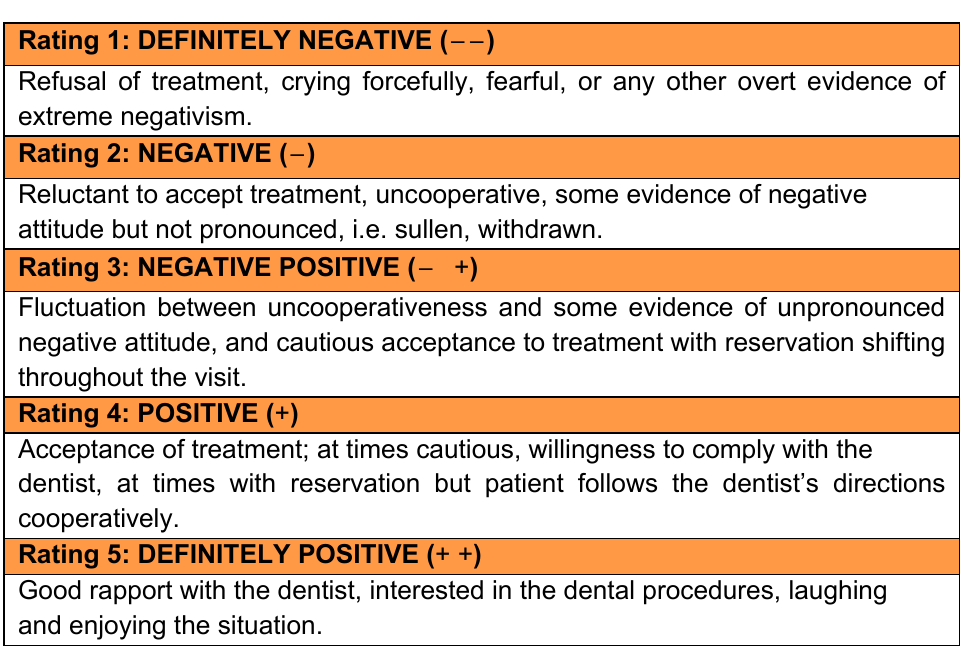
Figure 3. Modified Frankl scale (1975) to rate the degree of patient’s